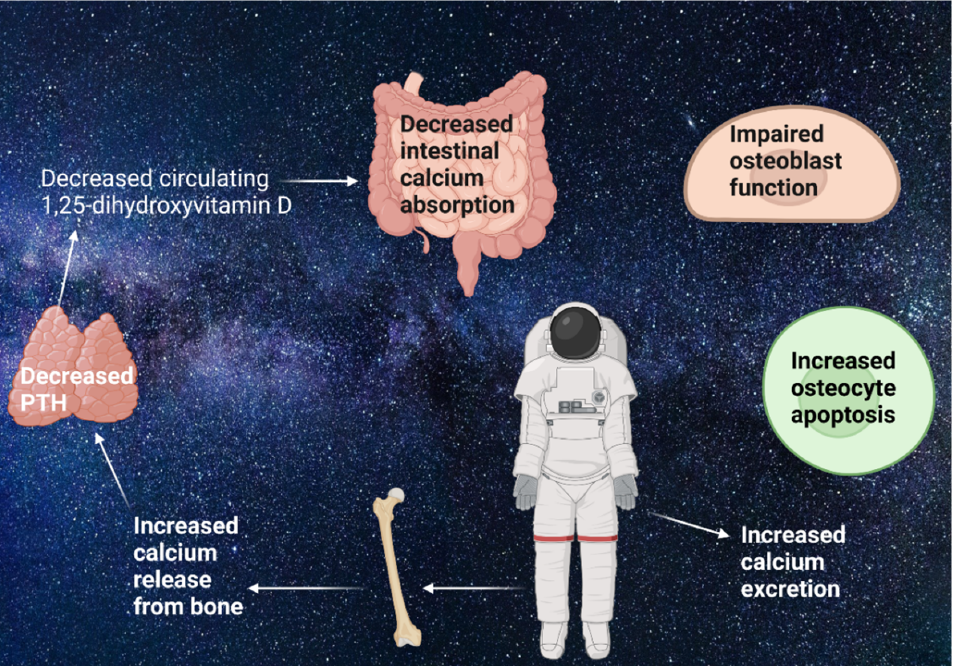
Figure 2. Mechanisms of microgravity (µ g )-induced bone loss: µ g releases calcium from bone, which suppresses the parathyroid hormone (PTH). Afterward, the suppressed PTH then lowers the circulating 1,25-dihydroxyvitamin D. This leads to decreased calcium absorption [24,26–28]. Additionally, osteoblast function is impaired, and osteocyte apoptosis is increased [5,32]. This results in unchanged or decreased bone formation and increased bone resorption, which leads to bone loss [22–24]. Created with BioRender.com (accessed on 27 July 2022).